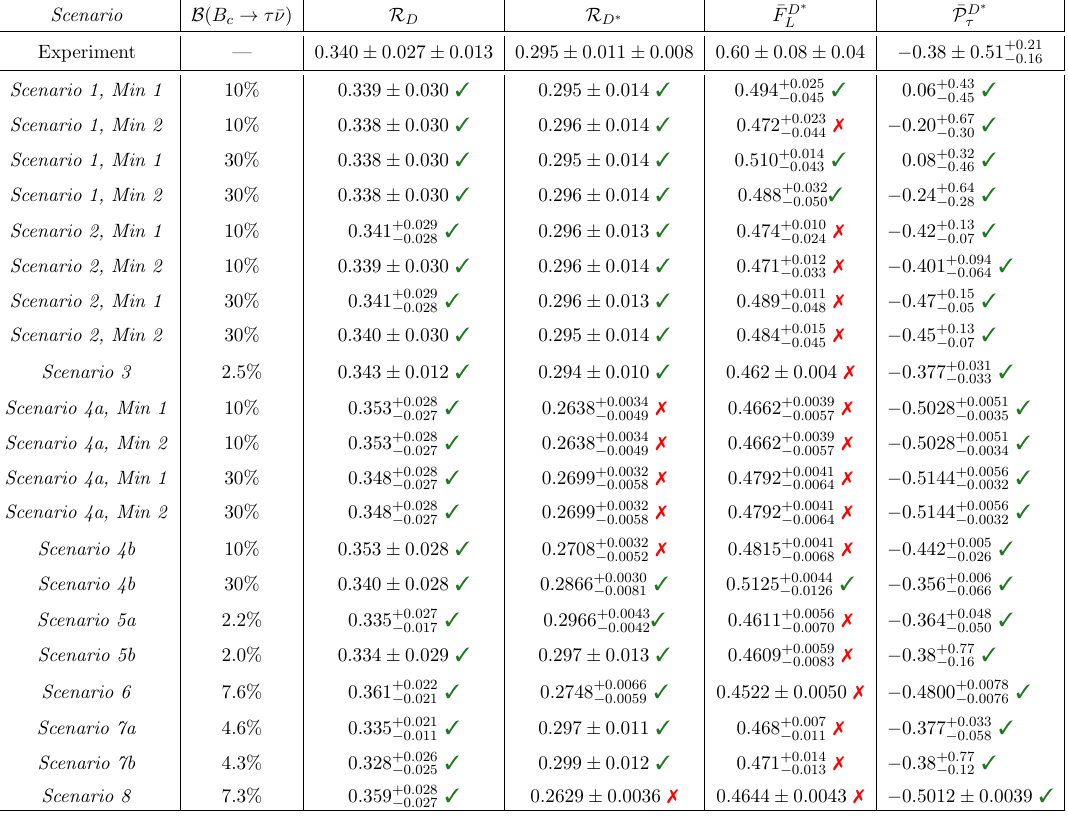
Table 4 . Predictions for the (cid:12)tted observables in the di(cid:11)erent minima, and their experimen- tal